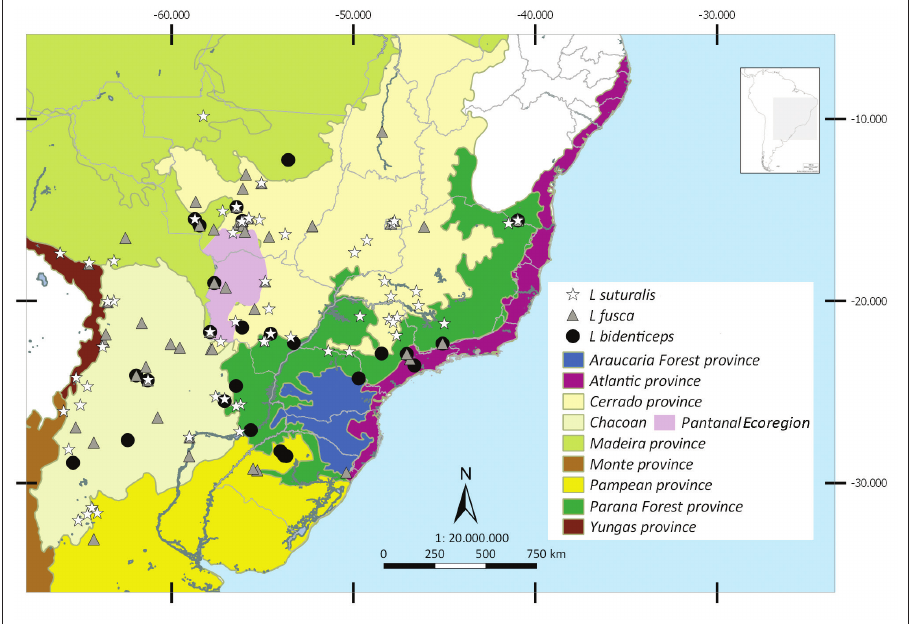
Figure 92. Distribution records of three species of Liogenys . Biomes based on Morrone (2014).